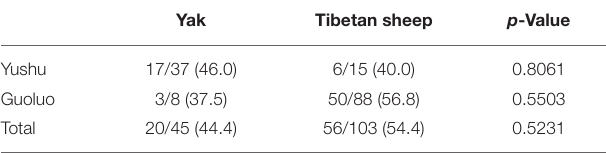
TABLE 3 | The patterns of infection rates of spotted fever group (SFG) Rickettsia in ticks, yaks, and Tibetan sheep grouped by prefecture and altitude of the sampling sites.